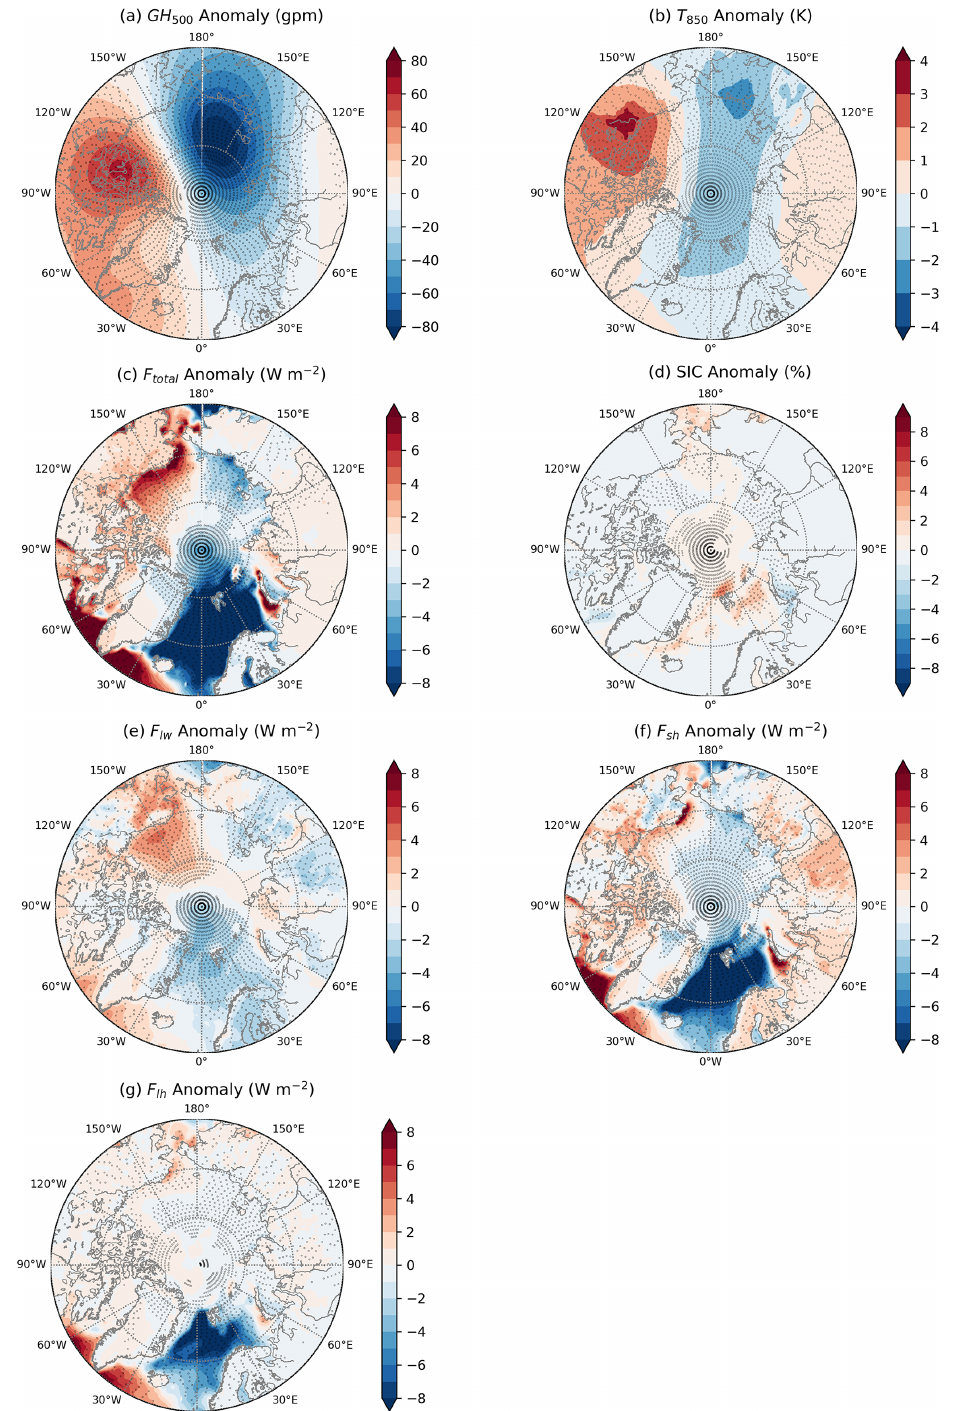
Figure 8. Anomalies of (a) 500hPa geopotential height (gpm), (b) 850hPa temperature (K), (c) F total , (d) SIC, (e) F lw , (f) F sh , and (g) F lh from linear regressions against daily f w time series over the Beaufort Sea. The stippling indicates statistical significance at the p < 0 . 05 level from a Student’s t test. Similarly to Fig. 2a, the linear regressions here are calculated against standardized f w . Therefore, the unit of the regression is same as the corresponding variables and the values represent the general anomalies from the climate mean during positive f w .